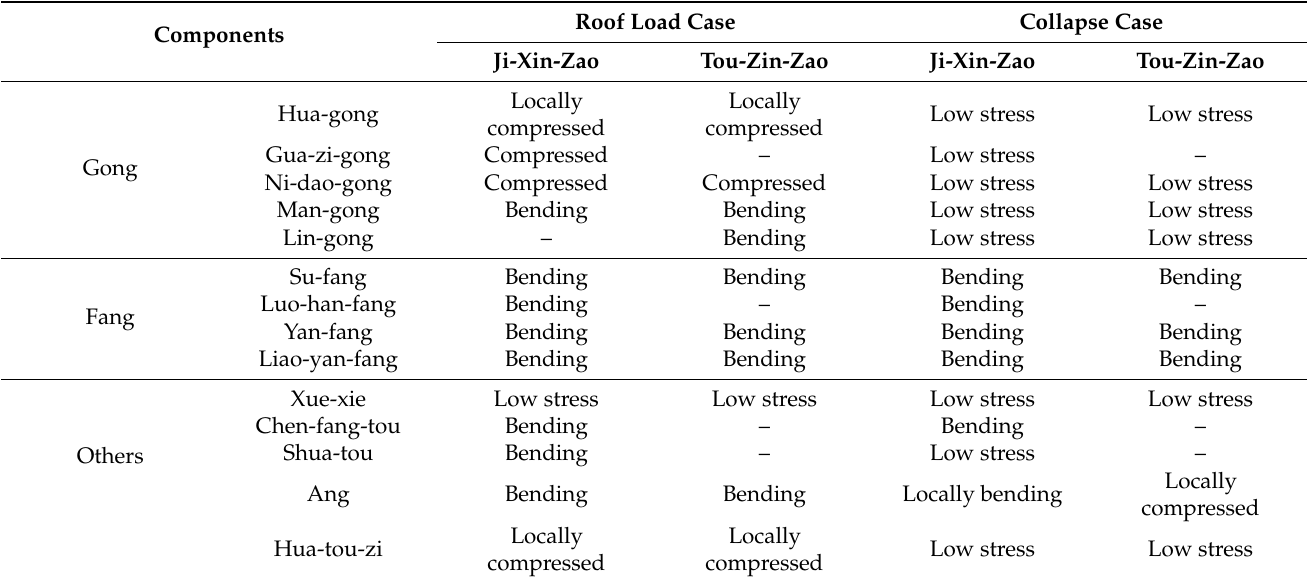
Table 2. Mechanical behavior of the components in the two